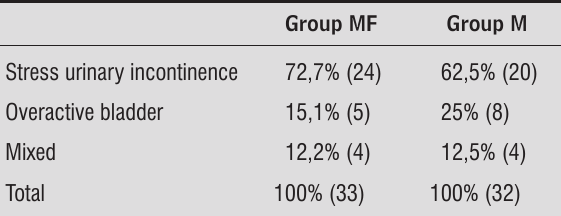
Table 1 - Characterization of both groups based on the urinary incontinence diagnosis